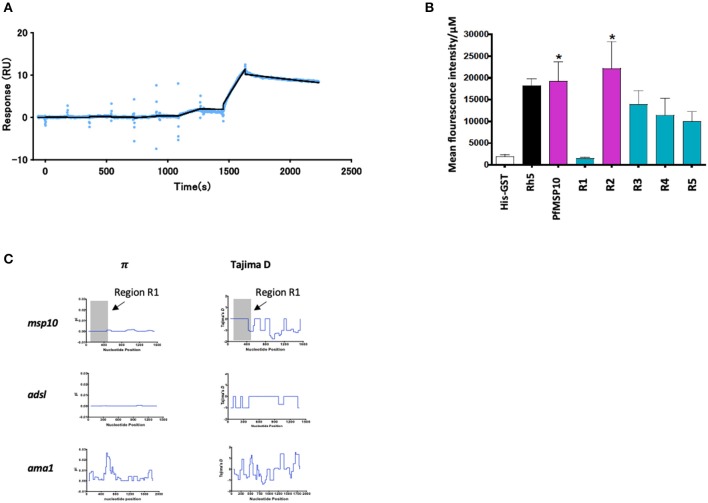
(A) SPR single-cycle kinetics analyses sensorgrams. Purified His-tagged recombinant PfGAMA was used as ligand and PfMSP10 R1 as analyte at increasing concentrations of 0.16, 0.8, 4, 20, and 100 nM. Blue dots indicate experimental data while black lines indicate line of fit used to calculate the kinetic parameters. (B) Ecto-PfMSP10 and PfMSP10 regions binding to erythrocyte surface were quantified by FACS and presented as mean fluorescence intensity. PfRh5 and His-GST were included as positive and negative controls, respectively. (C) Sliding window analysis showing nucleotide diversity (π) values and Tajima's D statistic in msp170. The gray box represents Region 1 of amino acid residues 29–188. Also analyzed as controls were Adsl, a highly conserved housekeeping gene; and ama1, a highly polymorphic protein.